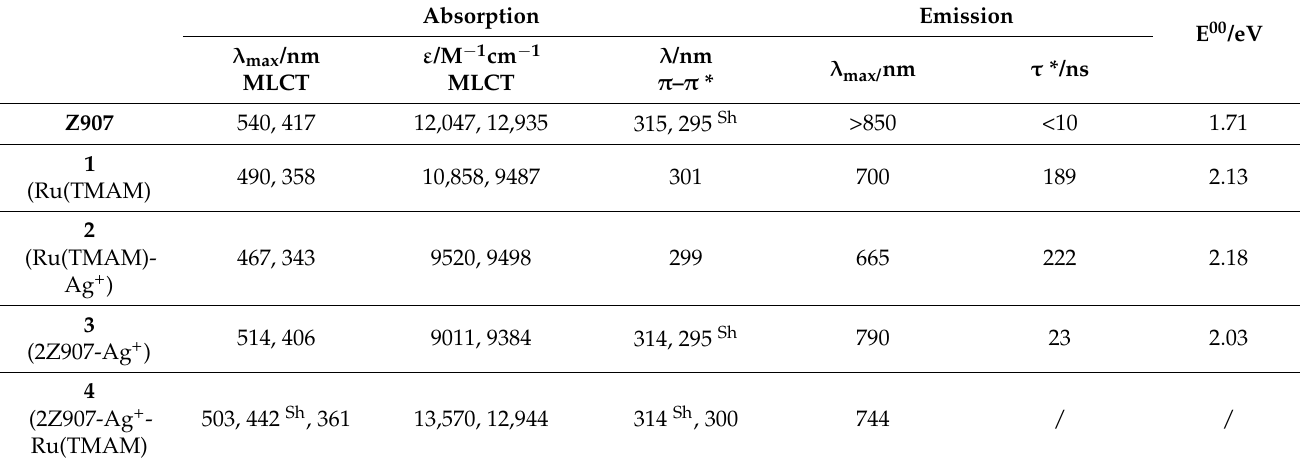
Table 1. Spectroscopic futures of the different systems in ethanol.